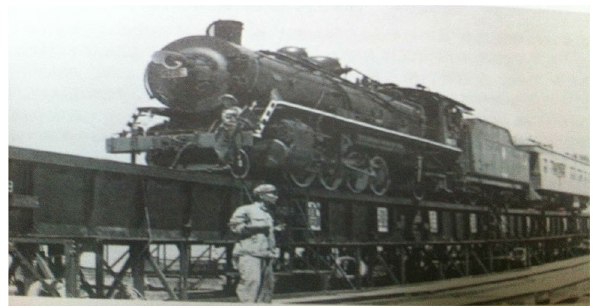
Fig. 18 Opening test of the 67-type railway pontoon bridge